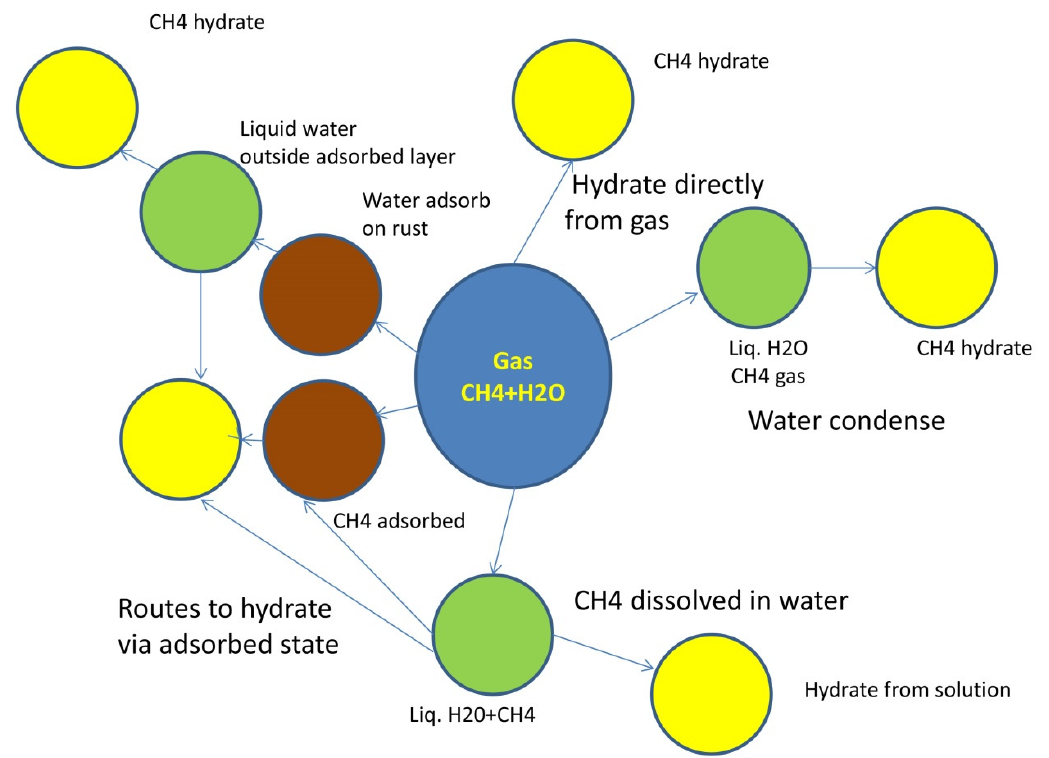
Figure 6. Illustration of various routes that can lead to hydrate formation during transport of CH 4 containing dissolved water. Yellow denote final hydrate formed. Green define water phase and brown define rust surface.